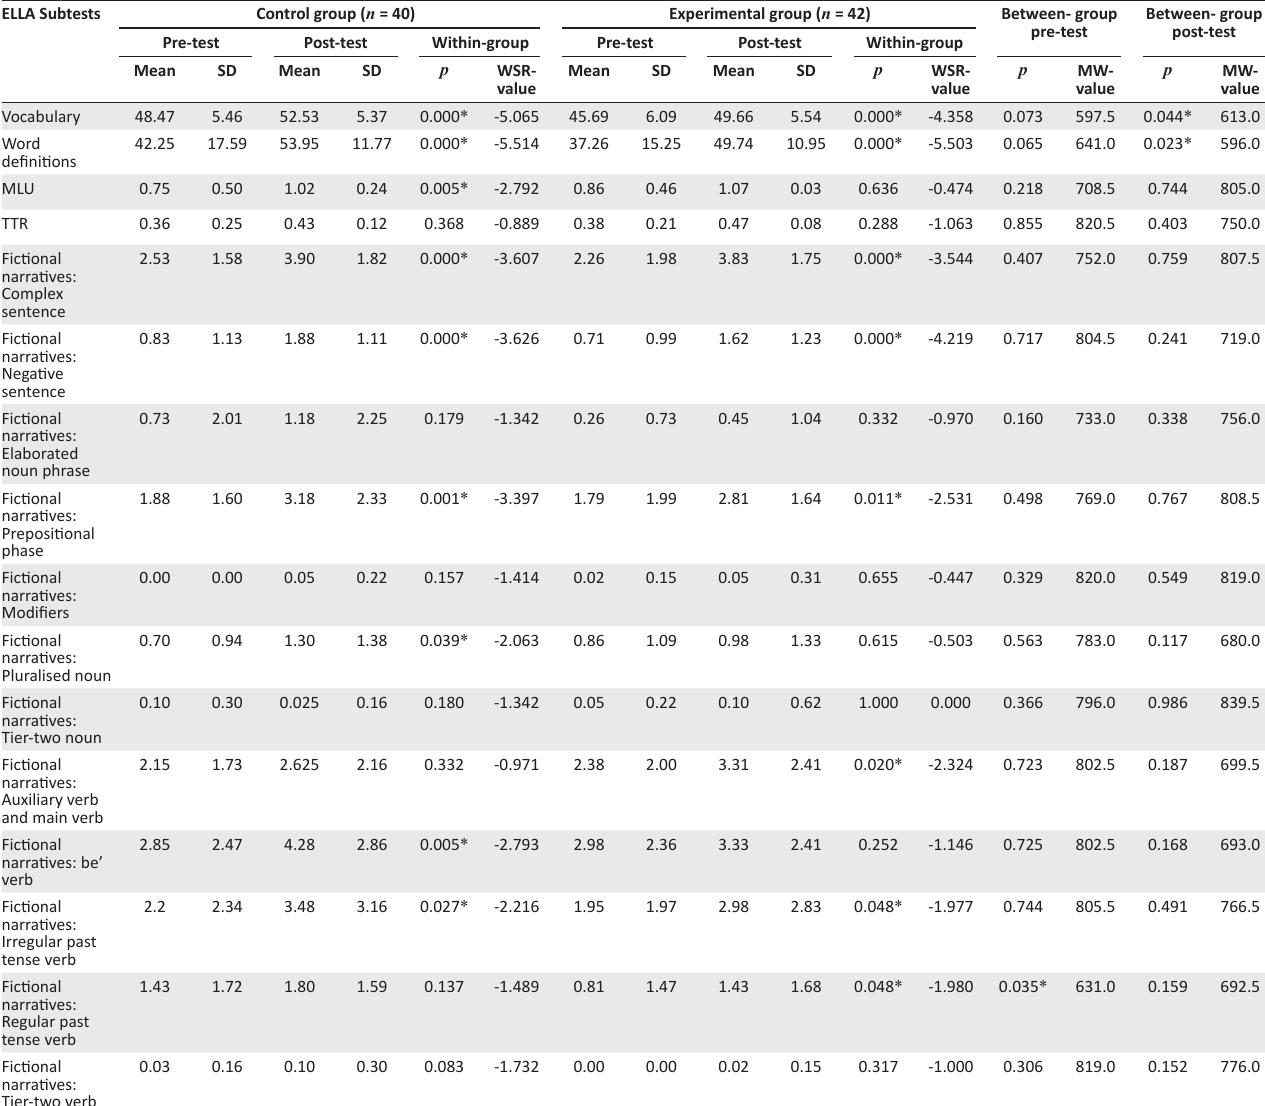
TABLE 1: Between- and within-group comparisons for the Emergent Literacy and Language Assessment Protocol subtest results. ELLA Subtests